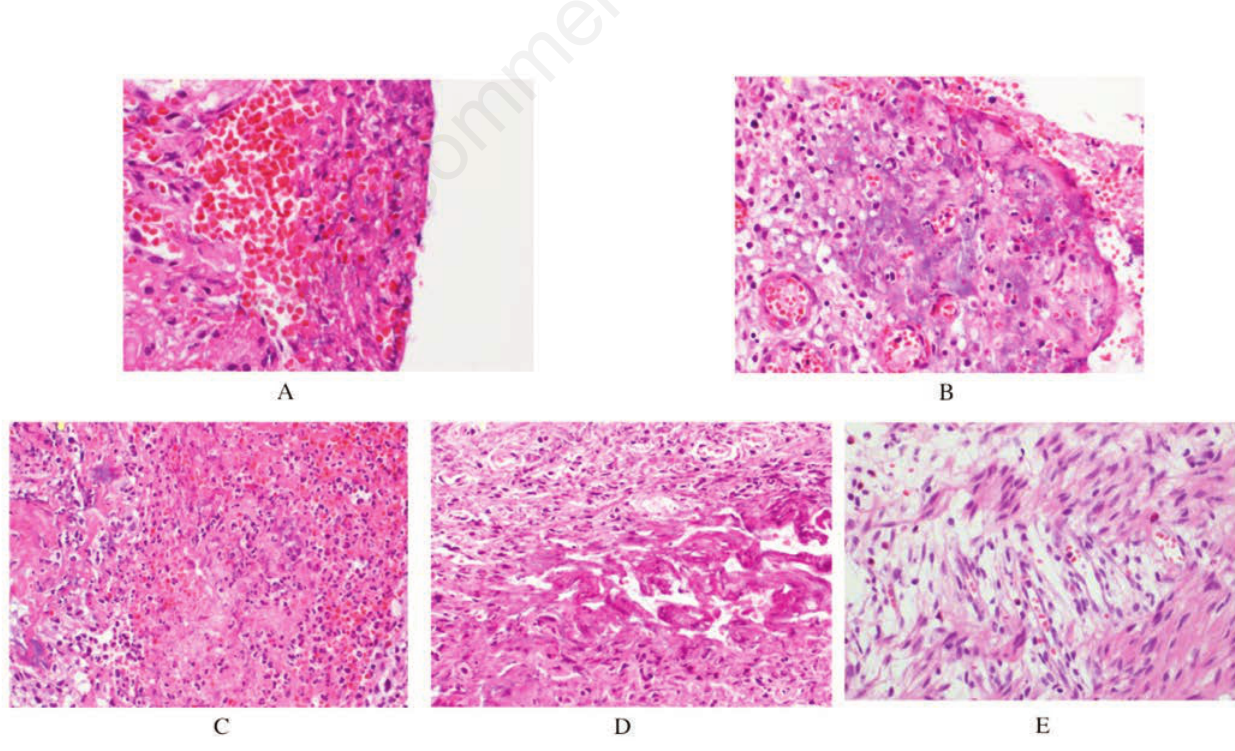
Figure 2. Histology in the resected intestinal segments at the side of stenosis (hematoxylin and eosin stain). A) colon, presence of gran- ulation tissue and smudget nuclei at lumen with ischemic changes (60X); B) colon, sloughand granulation tissue at luminal aspect (40X); C) colon, slough purulent (40X); D) colon, slough at sierosa (40X); E) colon, disrupted muscle edema and congestion